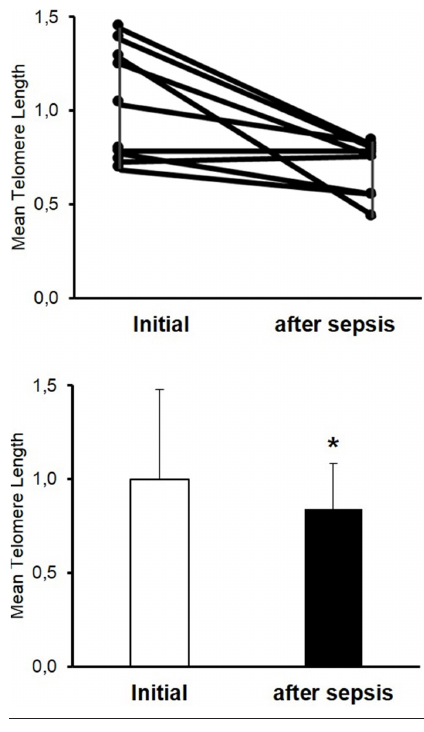
Figure 1. Endotoxemia induces telomere shortening. Analysis of telomere length (A) 1 h after and (B) 48 h after endotoxemia induction with LPS (15 mg/kg) in kidney, spleen and